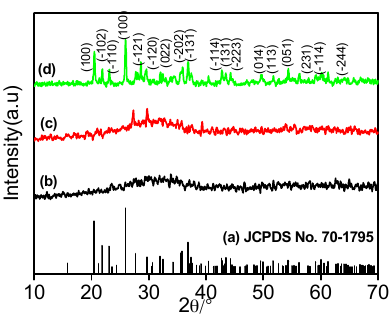
Figure 1. The powder X-ray diffraction (XRD) pattern of the ( a ) hexagonal Co 3 (PO 4 ) 2 —JCPDS No. 70-1795; ( b ) as-synthesized, calcined Co 3 (PO 4 ) 2 at ( c ) 300 °C; and ( d ) 300 °C.